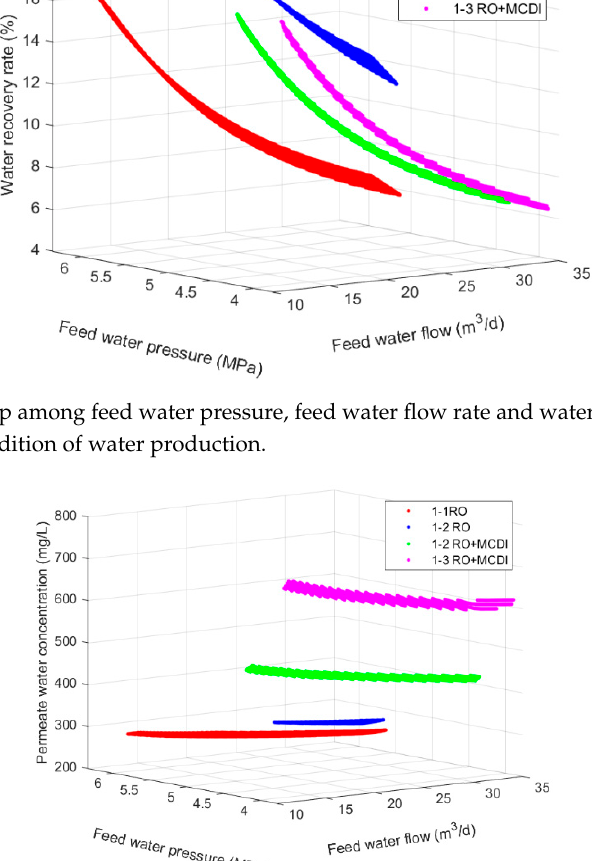
Figure 7. Relationship among feed water pressure, feed water flow rate and permeate water concentration of RO under constraint condition of water production.